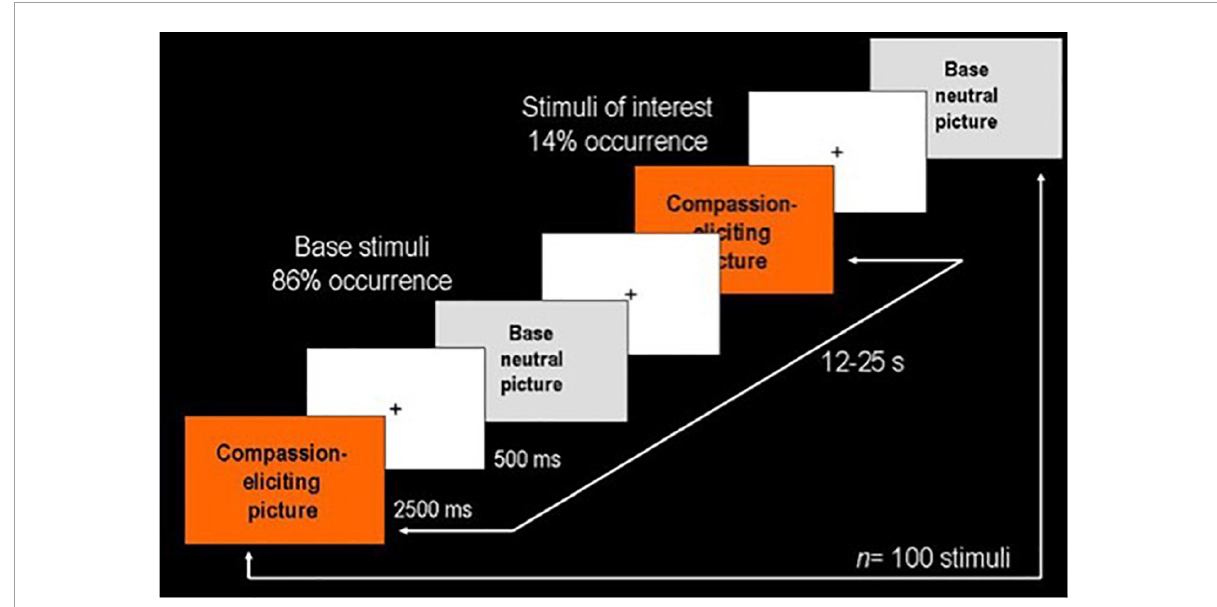
FIGURE1 Event-related design used in the presentation of visual stimuli. The series consisted of 100 pictures: 14 compassion-eliciting pictures depicting suffering in different contexts (stimuli of interest) and 86 neutral pictures representing common social scenes (base stimuli). Each stimulus was presented for 2,500 ms followed by a fixation cross for 500 ms. Stimuli of interest were randomly presented at 12–25 s